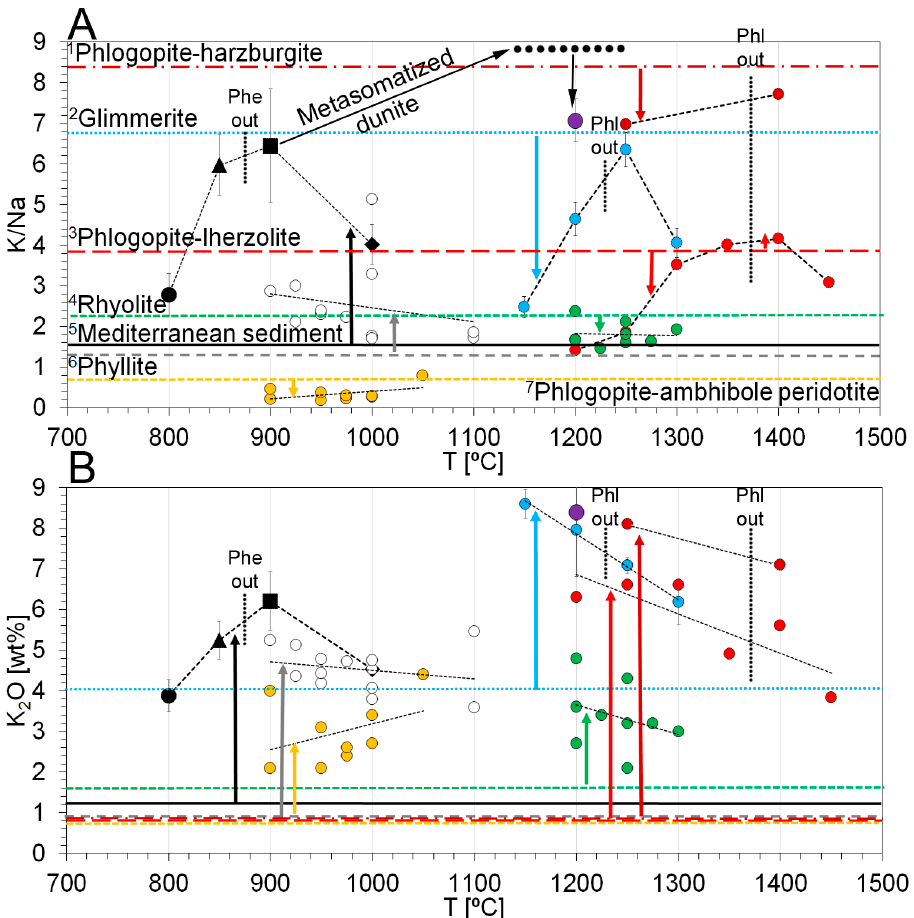
Figure 4. K/Na ( A ) and K 2 O mass fractions ( B ) of melts versus experimental run temperature (black circle 800 °C; triangle 850 °C; square 900 °C; diamond 1000 °C) and second-stage melts (purple circle) of this study compared with published data for phlogopite harzburgite and lherzolite (dark red and red circles [15]), hybridized rhyolite/peridotite (green circles [19]), glimmerite/harzburgite (blue circles [16]), hybridized phyllite/dunite (open white circles [20,31]), and phlogopite–amphibole peridotite (orange circles [55]). (A) Horizontal lines represent starting materials and are color-matched to the symbols for the same experiments. K/Na in melts shows peaks related to phengite breakdown at ca. 900°C and phlogopite breakdown at >1100 °C. Only experiments at <1100 °C generate melts in which K/Na ratios exceed those of the starting materials (upward facing arrows). At >1100 °C, the highest K/Na ratios approach those of the starting material (downward facing arrows). The arrow labelled “Metasomatized dunite” connects the 900 °C reaction experiment and the calculated starting composition (thick dotted line: Supplementary Data Table S2) of the second-stage experiment at 1200°C. (B) K 2 O mass fractions of experimental charges generally decrease with increasing temperature. Phengite-buffered K 2 O mass fractions in siliceous melts first increase with temperature and then decrease after phengite breakdown. Maximum mass fractions of K 2 O are <6 wt% for silica-rich melts (black symbols, white and green circles), while those buffered by phlogopite reach <9 wt% K 2 O (blue, purple, and red circles).